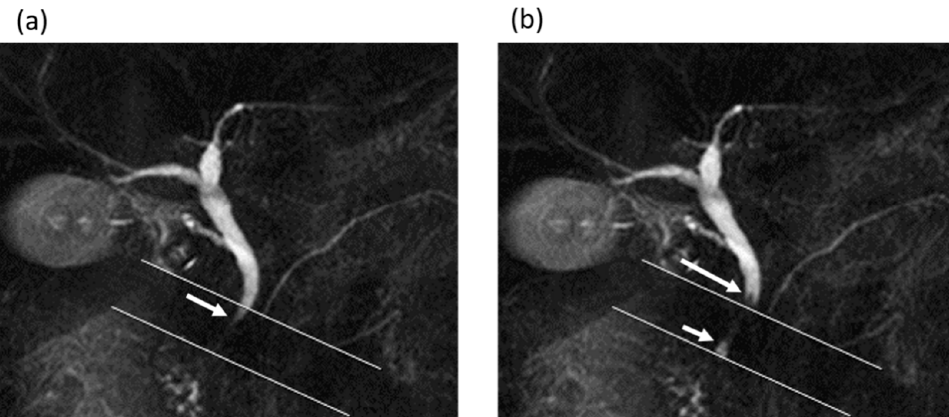
Figure 3. A 62-year-old man in the gallstone group. ( a , b ) Cine-dynamic MRCP images with a spatially selective IR pulse. ( a ) The antegrade bile flow appeared as high signal intensity (arrow) within the area of the IR pulse, showing a grading score of 2. ( b ) The reverse bile flow was seen as low signal intensity outside the area of the IR pulse (long arrow) and was also seen as high signal intensity coming from duodenal papilla side into the area of the IR pulse (short arrow). The grading score of reverse bile flow was classified as 1.